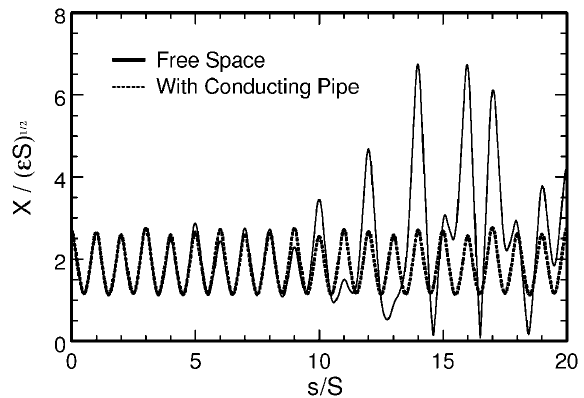
FIG. 6. Oscillations of the normalized beam envelope ~ aa (cid:4) p X= (cid:5)(cid:5)(cid:5)(cid:5)(cid:5)(cid:5) S" for both free-space and cylindrical conducting pipe (cid:4) 120 (cid:1) , and A (cid:4) ~ aa = ^ RR (cid:4) 0 : 9 , corre- cases with ^ KK (cid:4) 10 : 0 , (cid:1) v 0 sponding to a point in Fig. 5 where the envelopes in free space are unstable but the envelopes in cylindrical conducting pipe are stable.